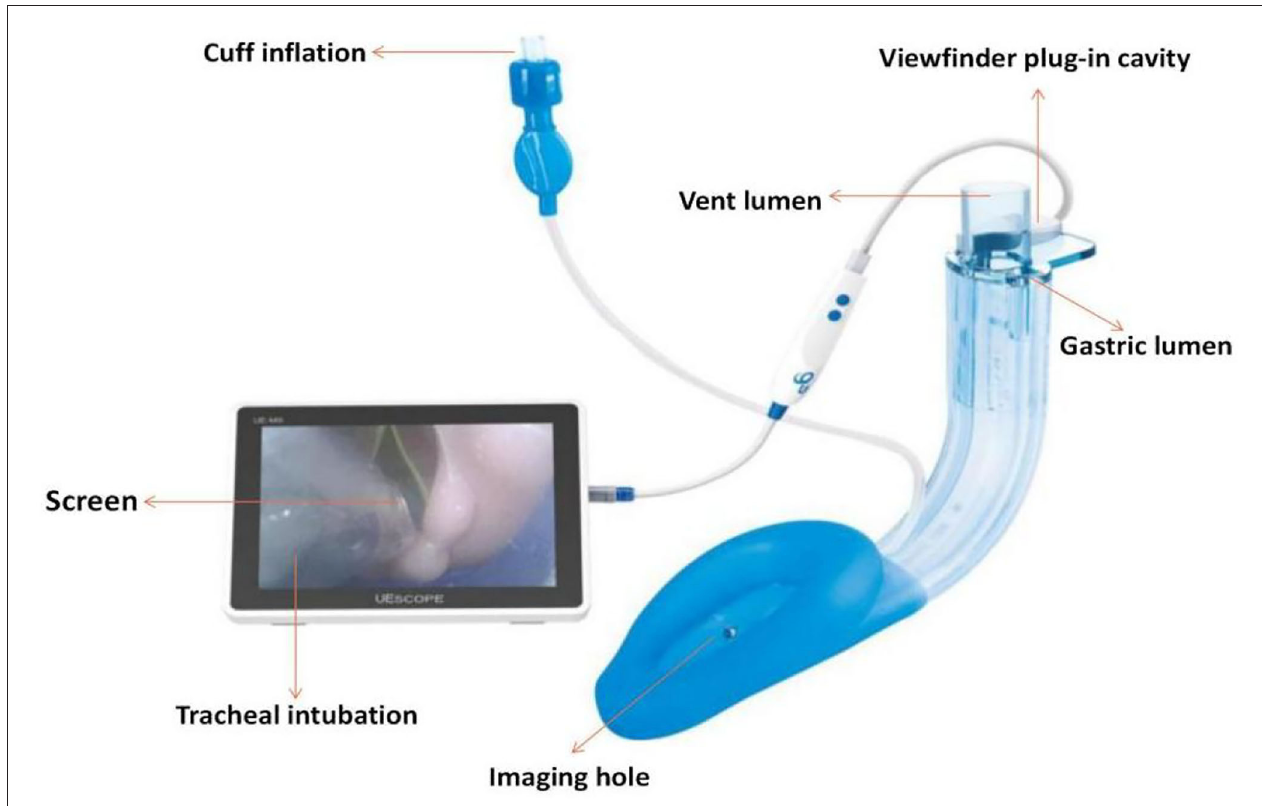
FIGURE 1 | SaCoVLM TM visible intubation laryngeal mask,photo courtesy of Youyi Medical Instrument Co. Ltd. (HangZhou,